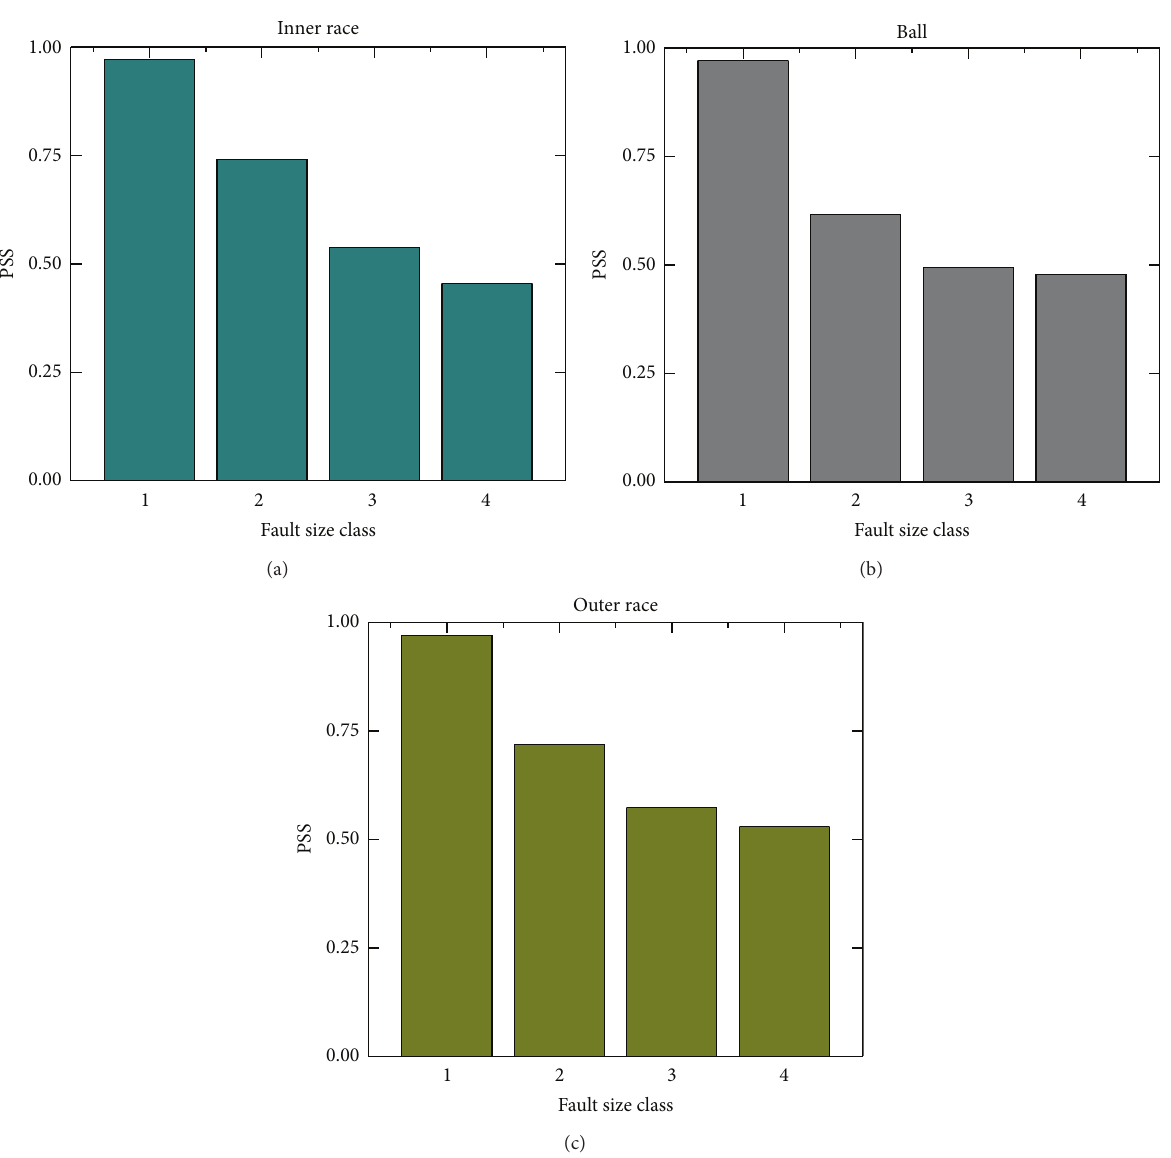
Figure 8: The PSS between two fault